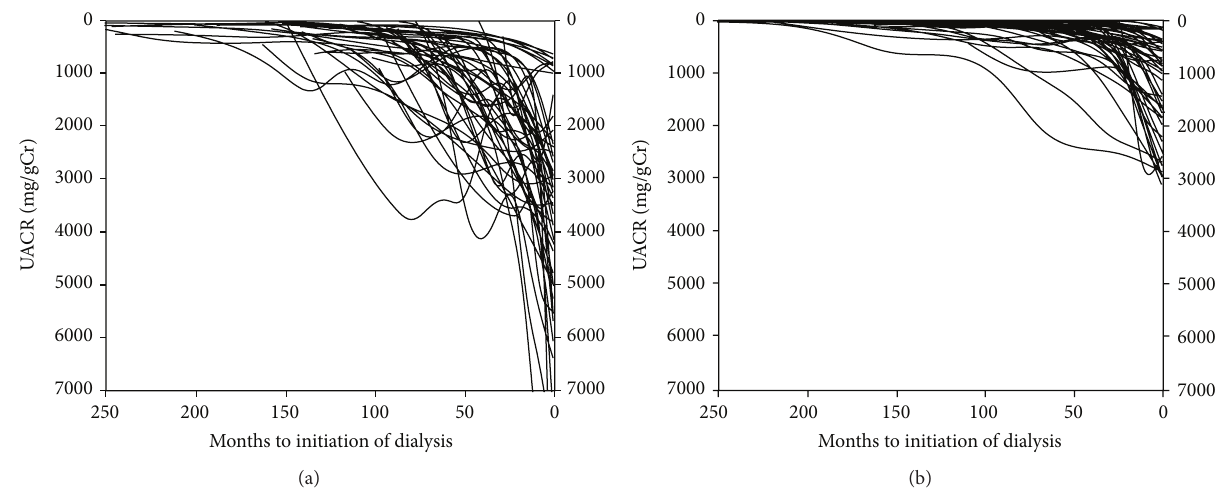
Figure 2: Urinary albumin to creatinine ratio (UACR) trajectories with individual slopes during the observation period in the two groups. (a) Smoothing curve for the diabetic nephropathy group; (b) smoothing curve for the nephrosclerosis